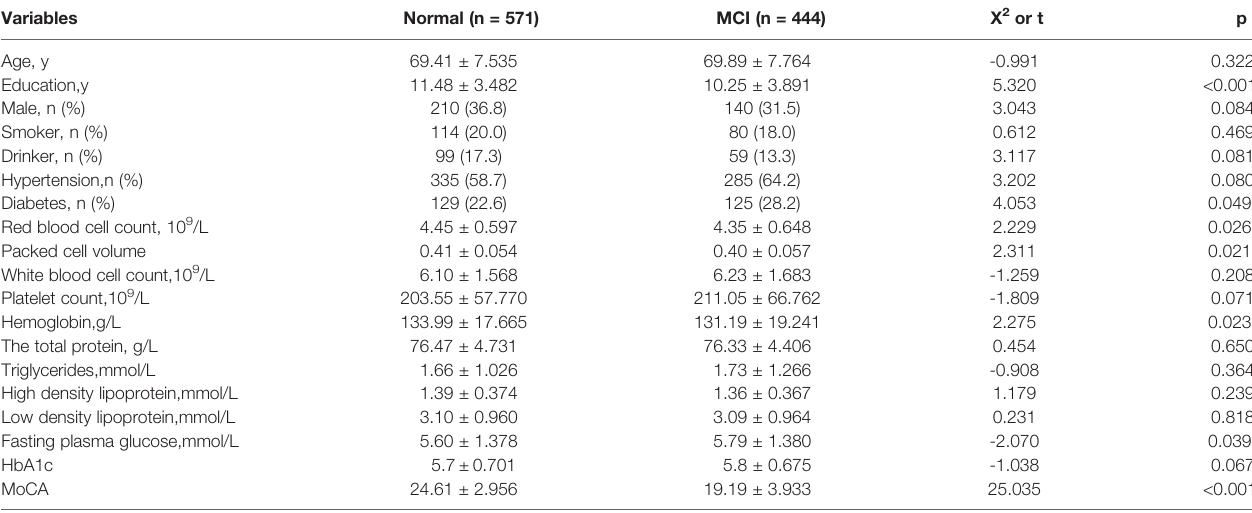
TABLE 1 | Comparison of general demographic data, blood routine and blood biochemical indexes between the two groups.